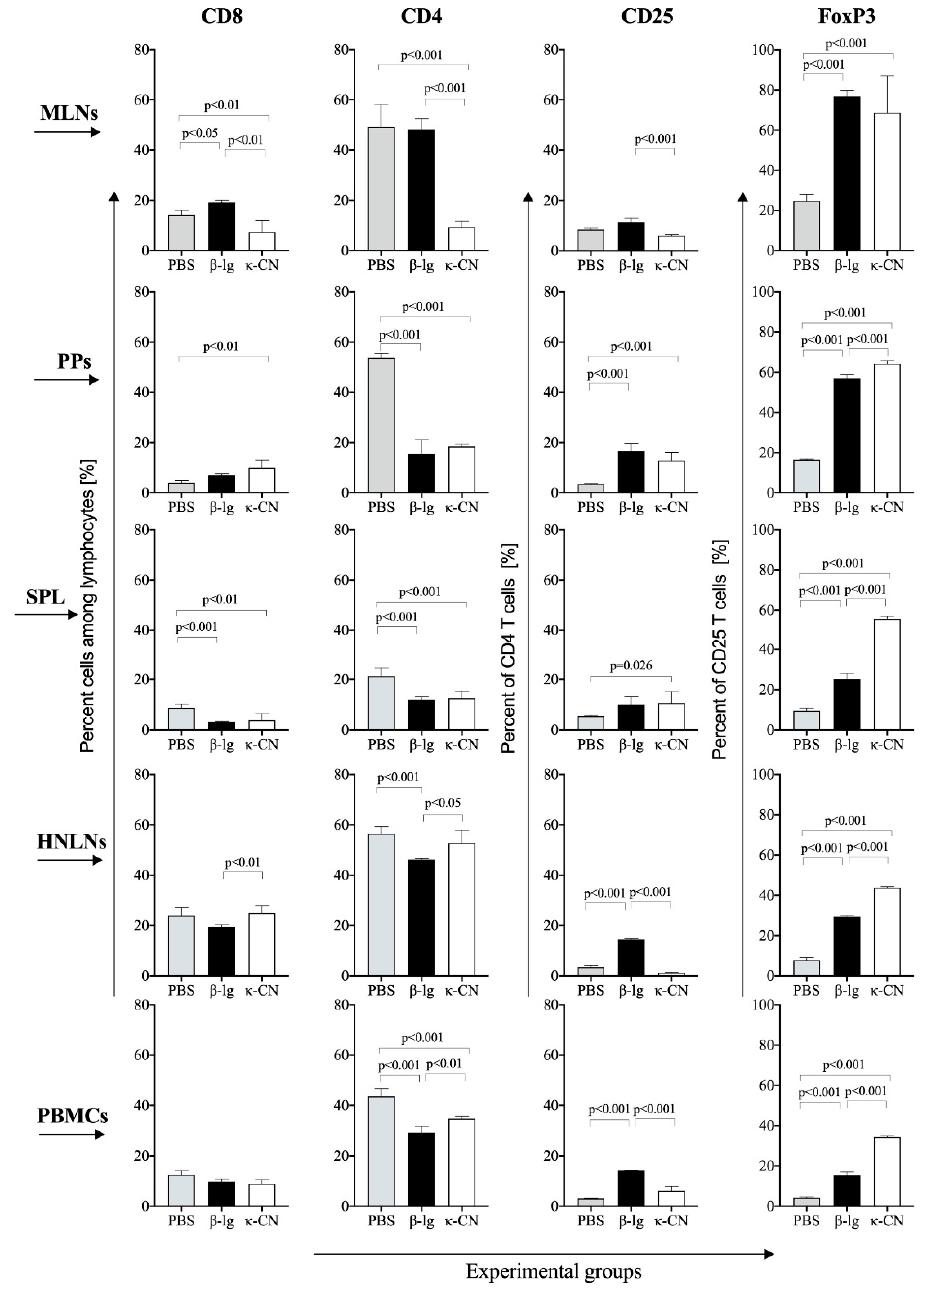
Figure 6. Distribution of CD8 + , CD4 + , CD4 + CD25 + , and CD4 + CD25 + Foxp3 + T cells in mesenteric lymph nodes (MLNs), Peyer’s Patches (PPs), spleen (SPL), head and neck lymph nodes (HNLNs), and peripheral blood mononuclear cells (PBMCs) of mice immunized with β -lg (black bars) or κ -CN (white bars) and control mice treated with PBS only (gray bars). The data are expressed as the means ± SD. Statistical analysis was performed with one-way ANOVA follow by Tukey’s post-hoc test. CD4 + T cells are precursors for regulatory cells, induced and regulated in various molecular pathways. To show the differentiation of CD4 + cells, we checked CD4 + CD25